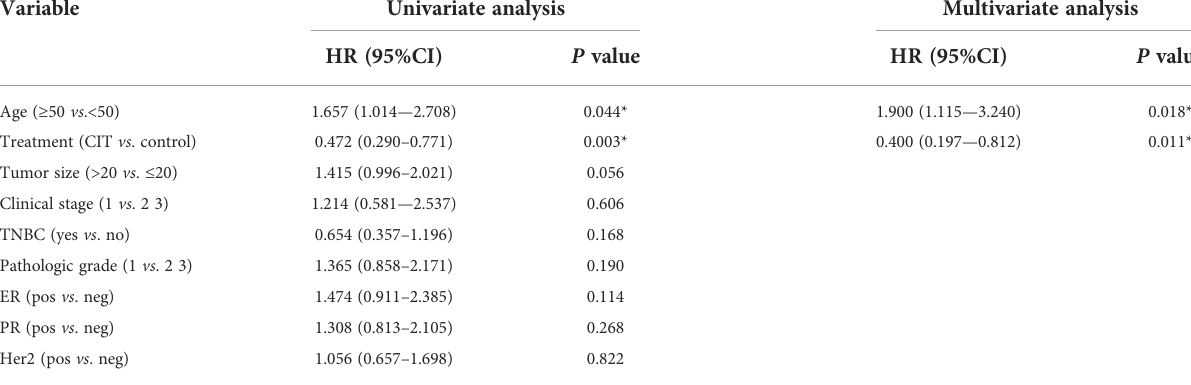
TABLE 4 Univariate and multivariate analysis of overall survival for breast patients in the CIT and control groups. Variable